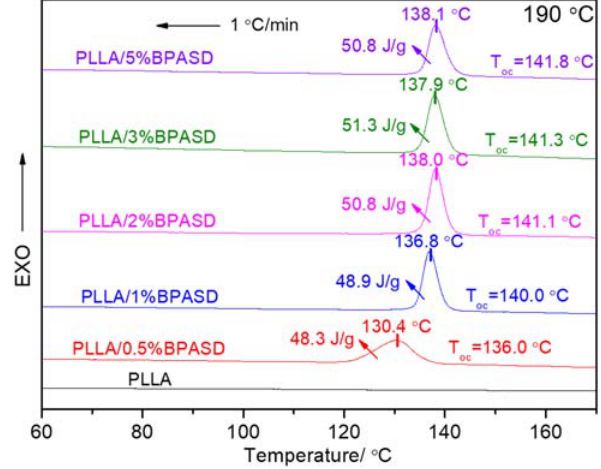
Figure 2: Melt - crystallization DSC curves of the virgin PLLA and all PLLA/BPASD